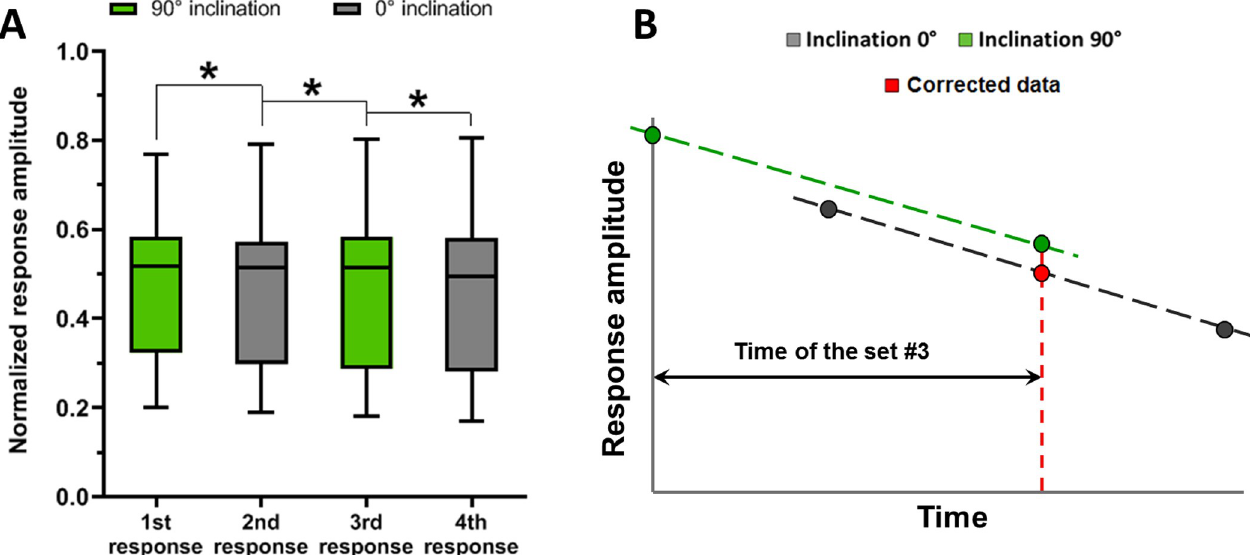
Fig 4. Analysis of gradual changes in the response maximum. (A) Differences in the amplitude maximum of the average responses to blue flashes recorded one after another with certain time intervals (normalized by response amplitude, achieved for a given preparation). For all retinal preparations (n = 31) responses show significant decreasing of the amplitude maximum. Data presented as medians (black horizontal lines) and quartiles (boxes and bars). � — statistically significant changes for one-way repeated measures ANOVA with post hoc Bonferroni correction. (B) Pair of responses recorded under the same 0˚ inclination of MF was used for building the linear trend in the amplitude of photoreceptor responses over time, and then such calculated trend was used for calculation of corrected response amplitude at the same time point as the amplitude for inclination 90˚. The value of amplitude used for subsequent statistical analysis is marked as “corrected